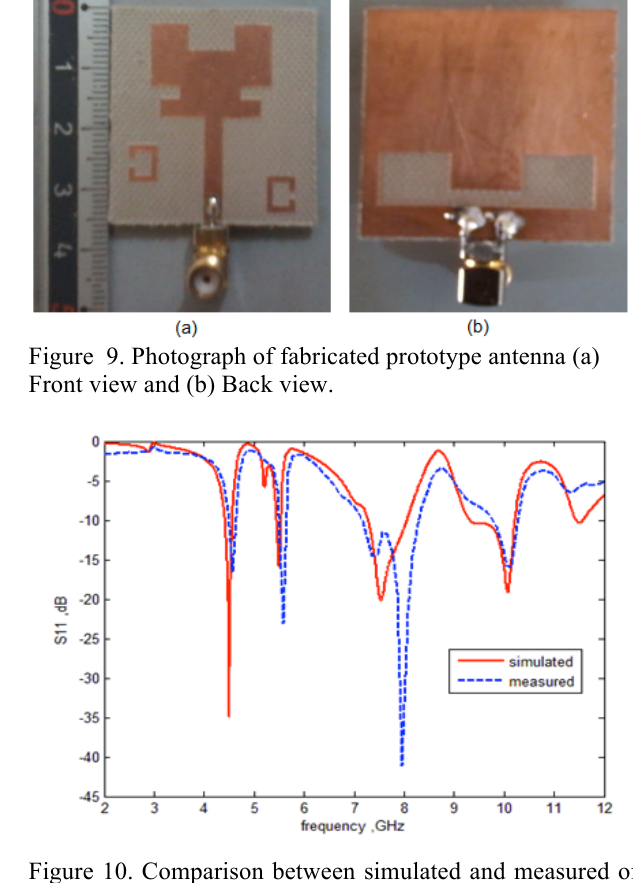
Figure 10. Comparison between simulated and measured of the input re fl ection